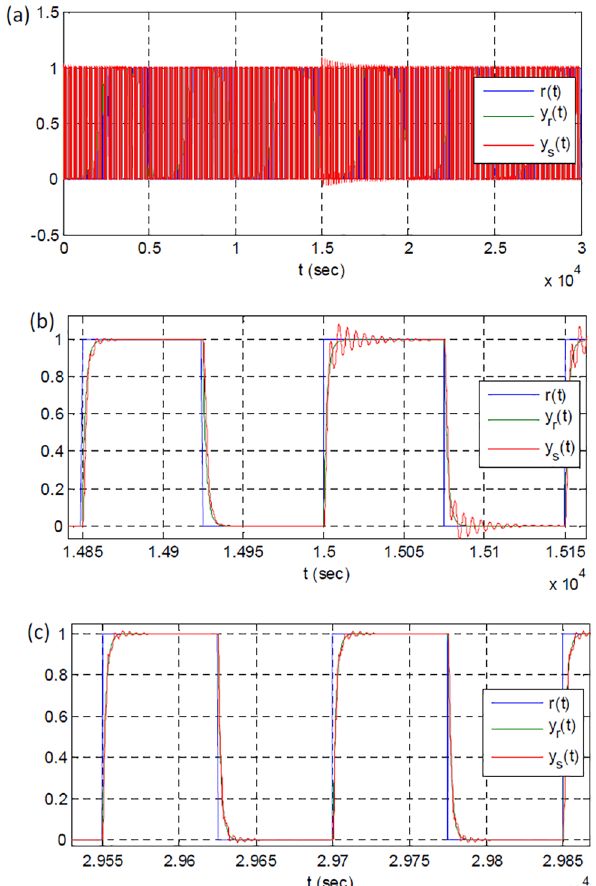
Fig 7. Referenceinput, outputs of reference model and the plant: (a) a view of full-time simulation, (b) a close view of initial responsefor the plant perturbation, (c) a close view of final